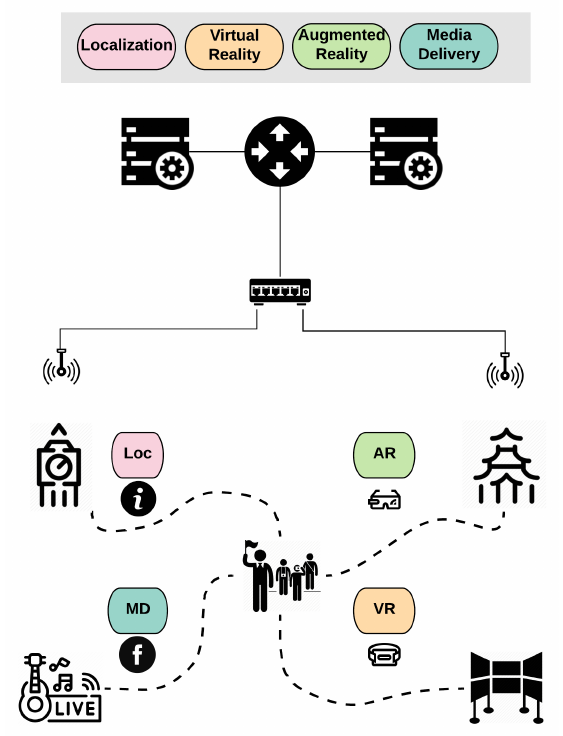
Figure 4. Mobility-aware edge